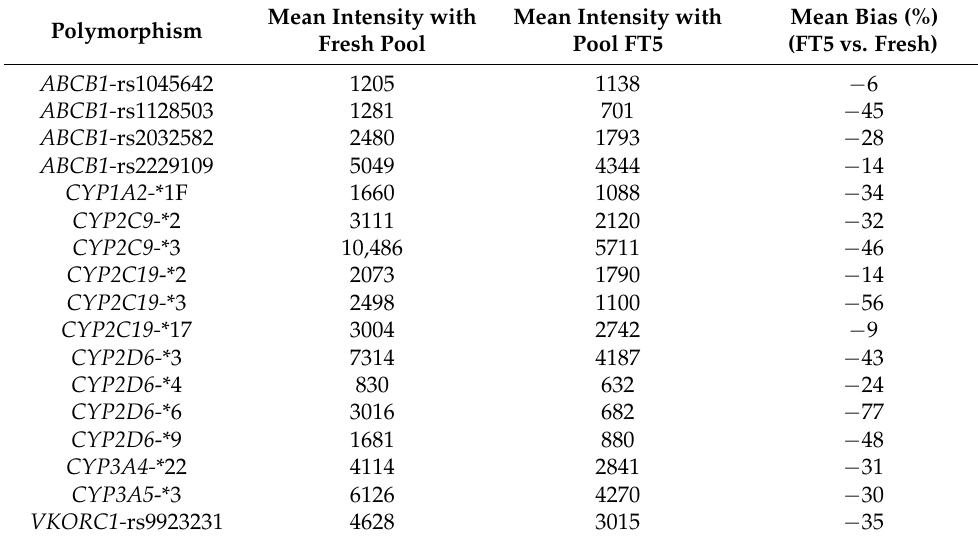
Table 3. Stability of the ready-to-use pool of primers and